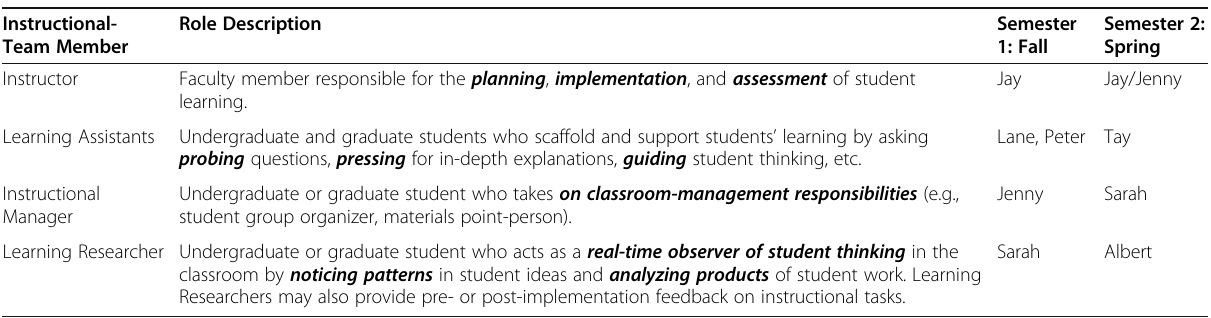
Table 1 Instructional-team-member